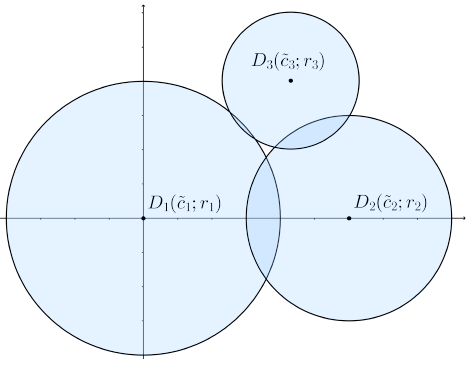
Figure 9. Affin configuration of the d -disk system.